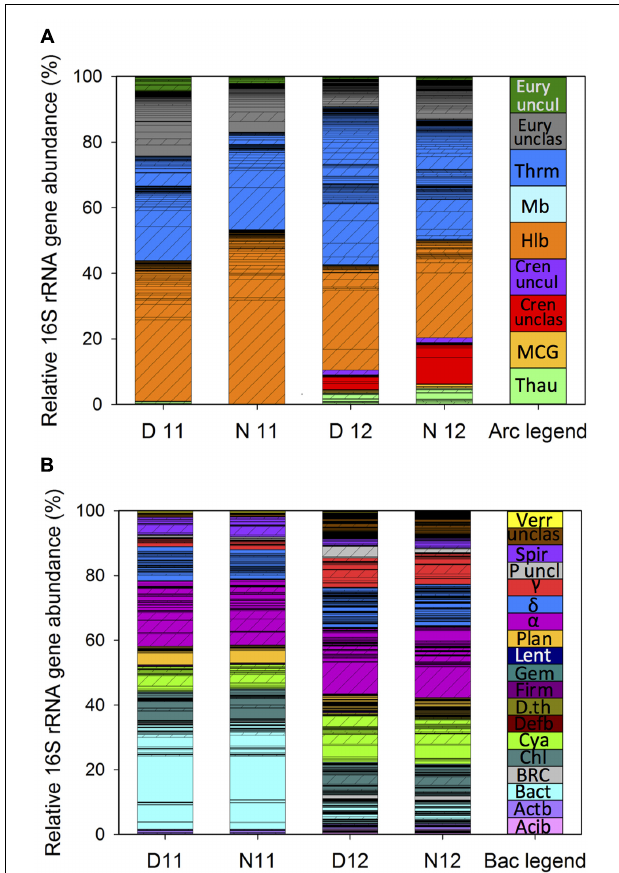
FIGURE 1 | Stacked bar charts of microbial mat community profiles for Archaea (A) and Bacteria (B) based on relative 16S rRNA gene abundance of operational taxonomic units (OTUs) sorted by phylogenetic classification during day and night under high (2011) and lower salinity (2012). Bars represent the average ( n = 6) relative 16S rRNA gene abundance of each OTU under the following conditions: D11, day 2011; N11, night 2011; D12, day 2012; N12, night 2012. Standard deviations for OTUs are located in the Supplemental Table S4. Cross hatched bars represent OTUs present under both salinities. Phylogenetic classification was made with Silva archaea or bacteria reference files using the 16S rRNA gene MiSeq sequencing data. (A) : Thau, Thaumarchaeota; MCG, Miscellaneous Crenarchaeotic Group; Cren unclas, Crenarchaeota unclassified;